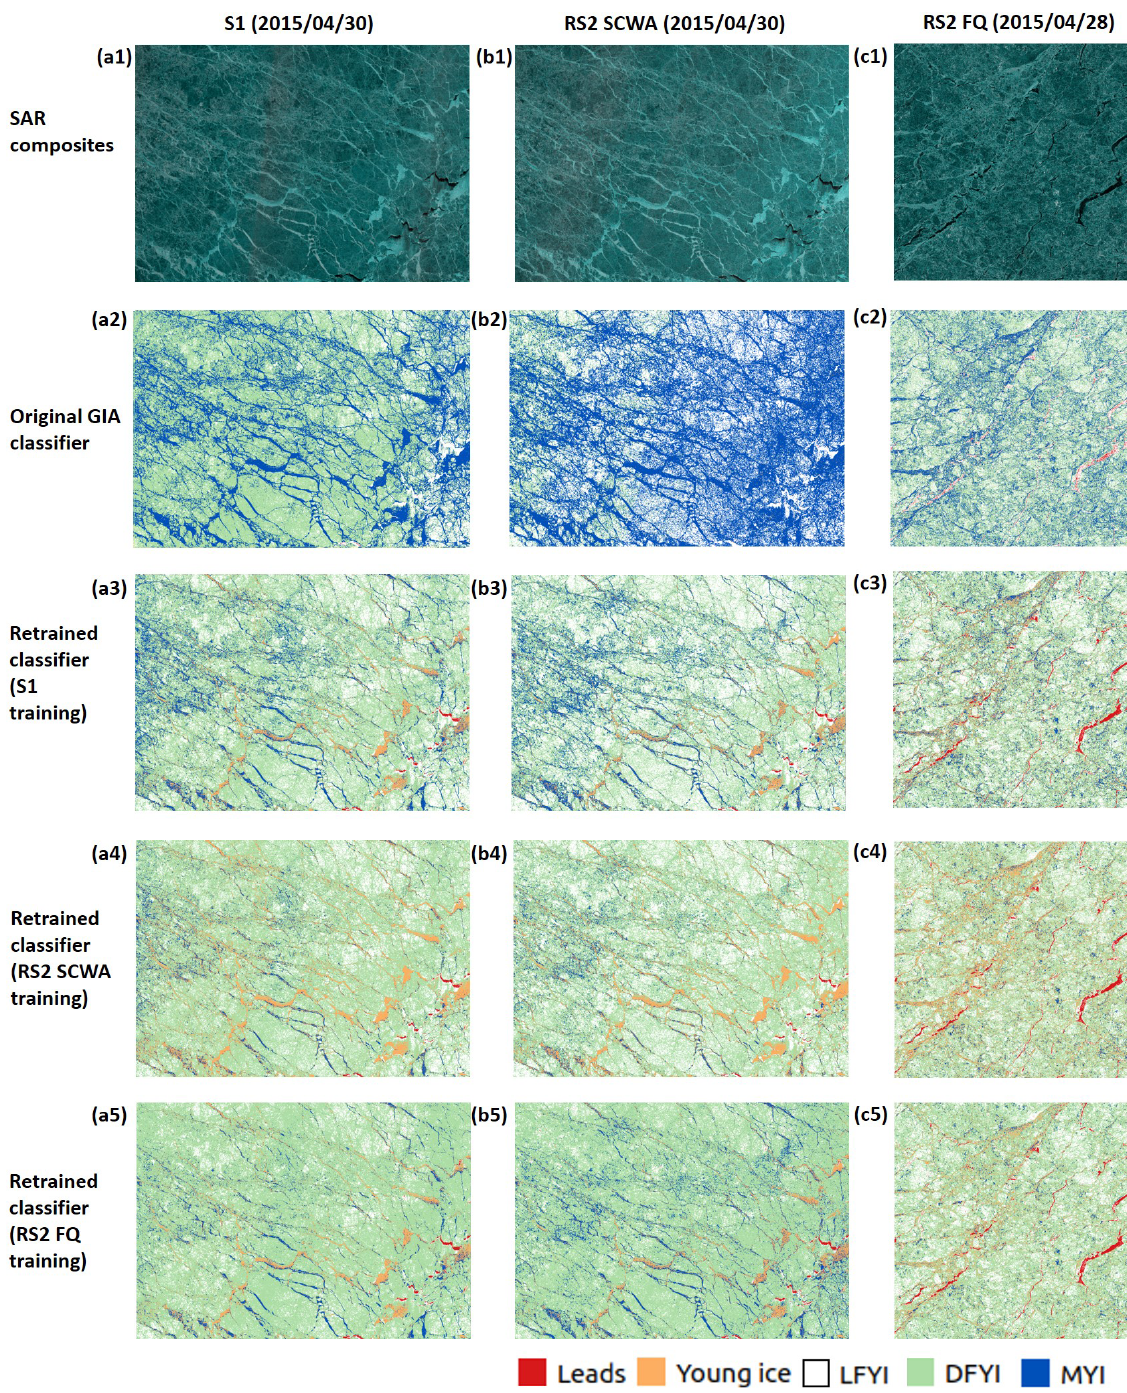
Figure 6. Example comparisons between classification results using the GIA classifier with different